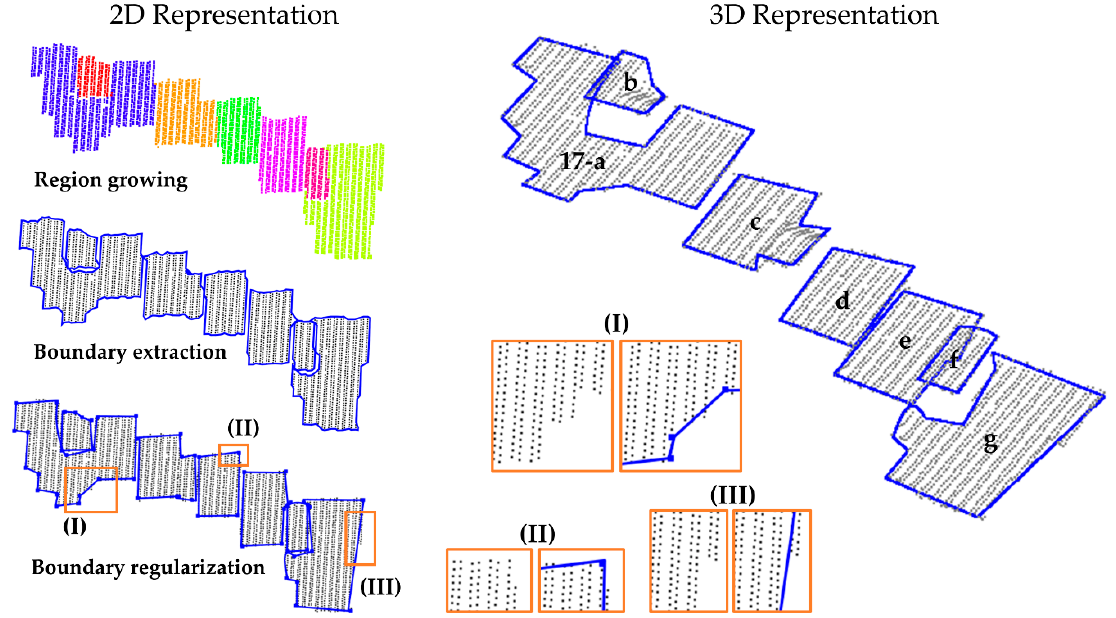
Figure 13. Building 17 in Vaihingen/Germany dataset. Results derived from region growing ( top left ), boundary extraction using the adaptative alpha-shape algorithm ( middle left ) and boundary regularization using the iterative CD-spline ( bottom left ). 3D representation of regularized boundaries ( right ).